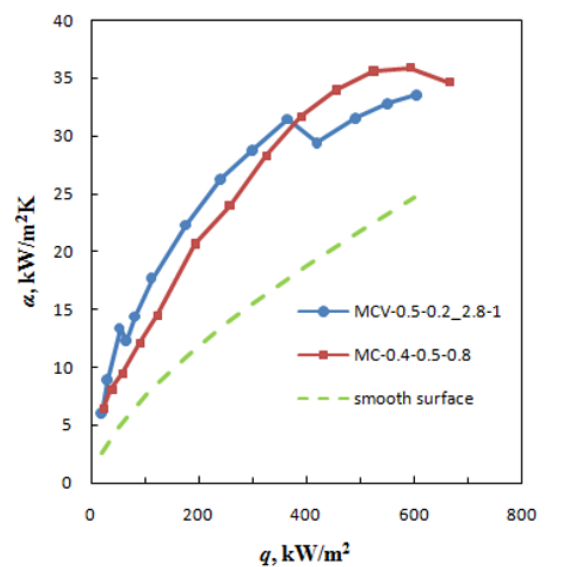
Fig. 6. Boiling curves for water, heat transfer coefficient vs. heat flux.